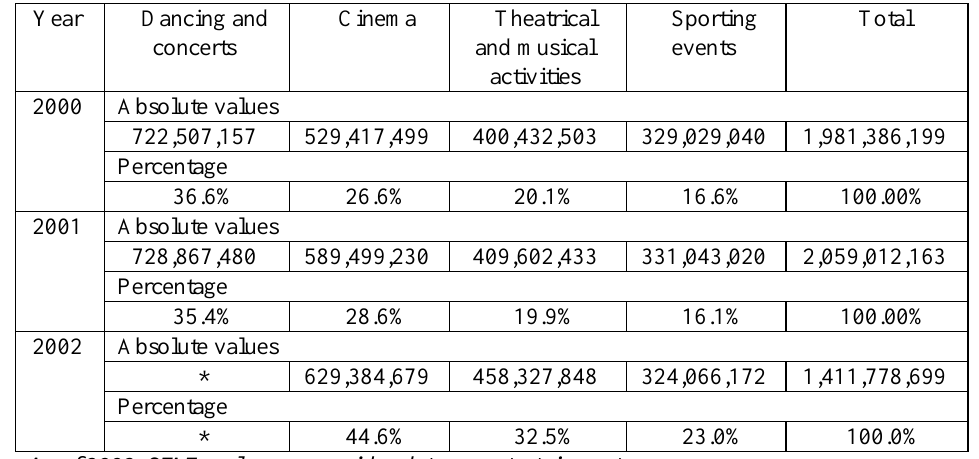
Figure 2: Expenditure Trends for Events, 2000 to 2002 in Italy (Absolute Values in Euros and